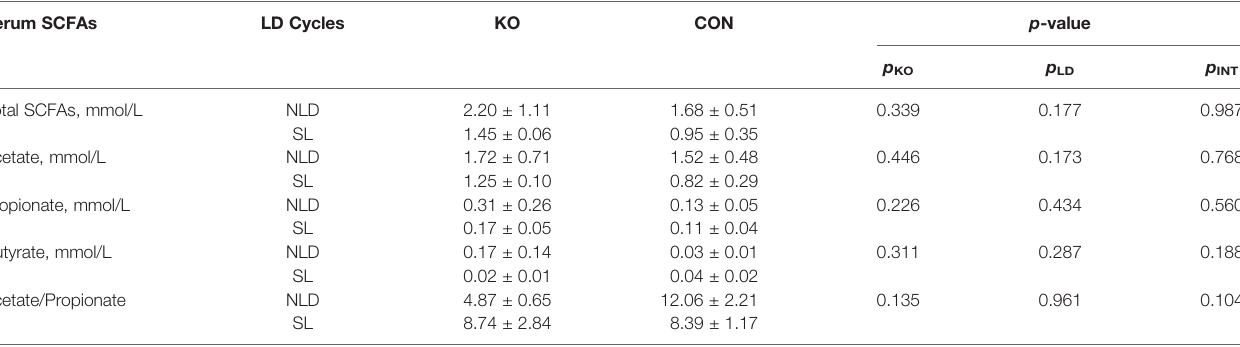
TABLE 1 | Concentrations of SCFAs in serum. Serum